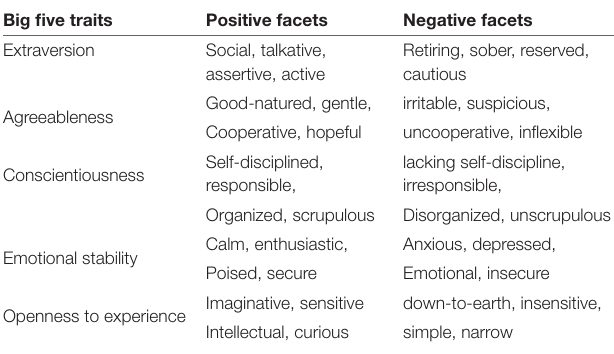
TABLE 1 | Positive and negative facets of the BIG-5 personality traits (Neuman et al., 1999). Big five